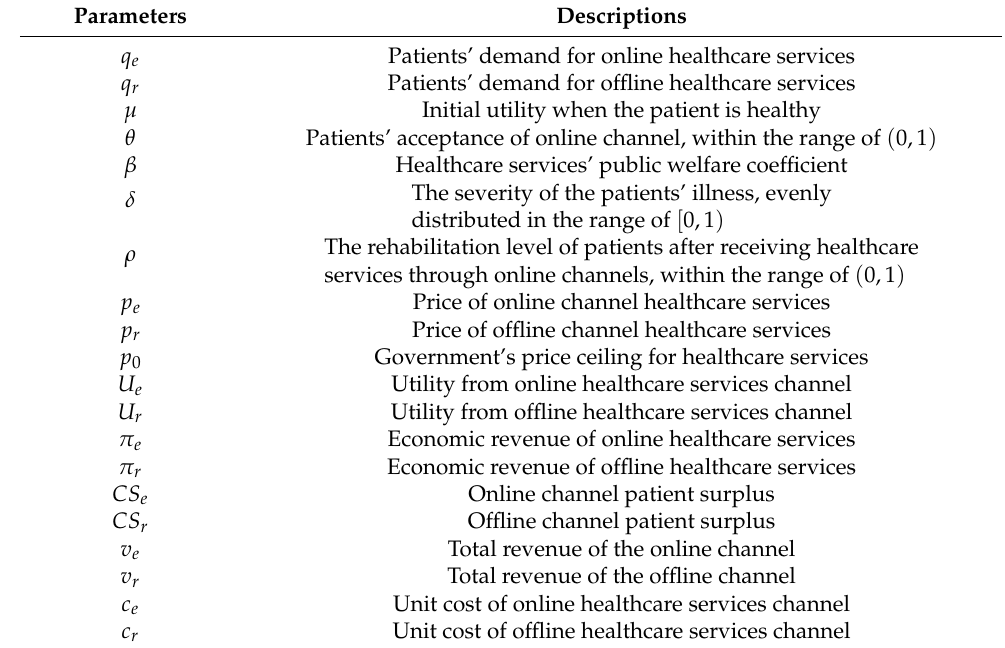
Table 1. Symbols and notations used in the